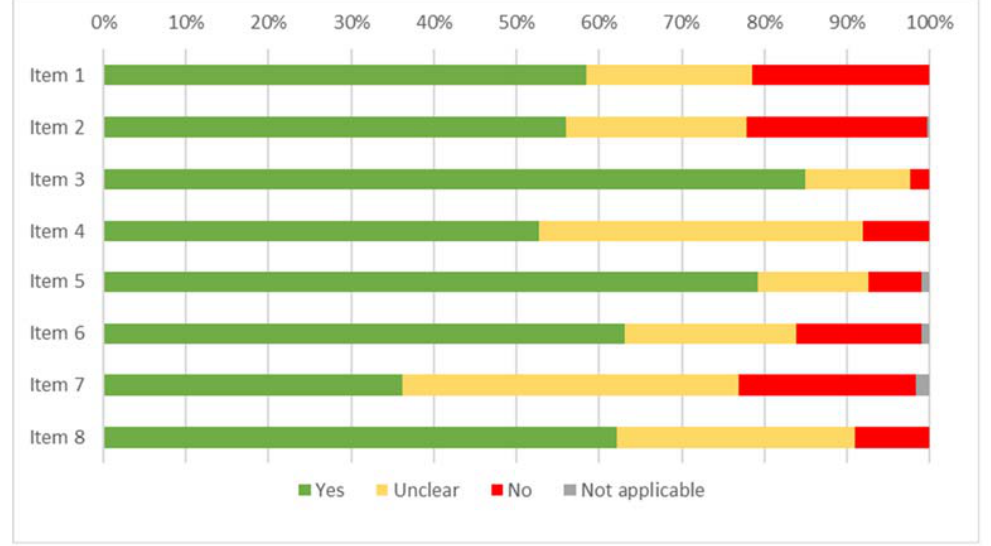
Figure 2. Summary of the critical appraisal process of the case reports according to the JBI tools.